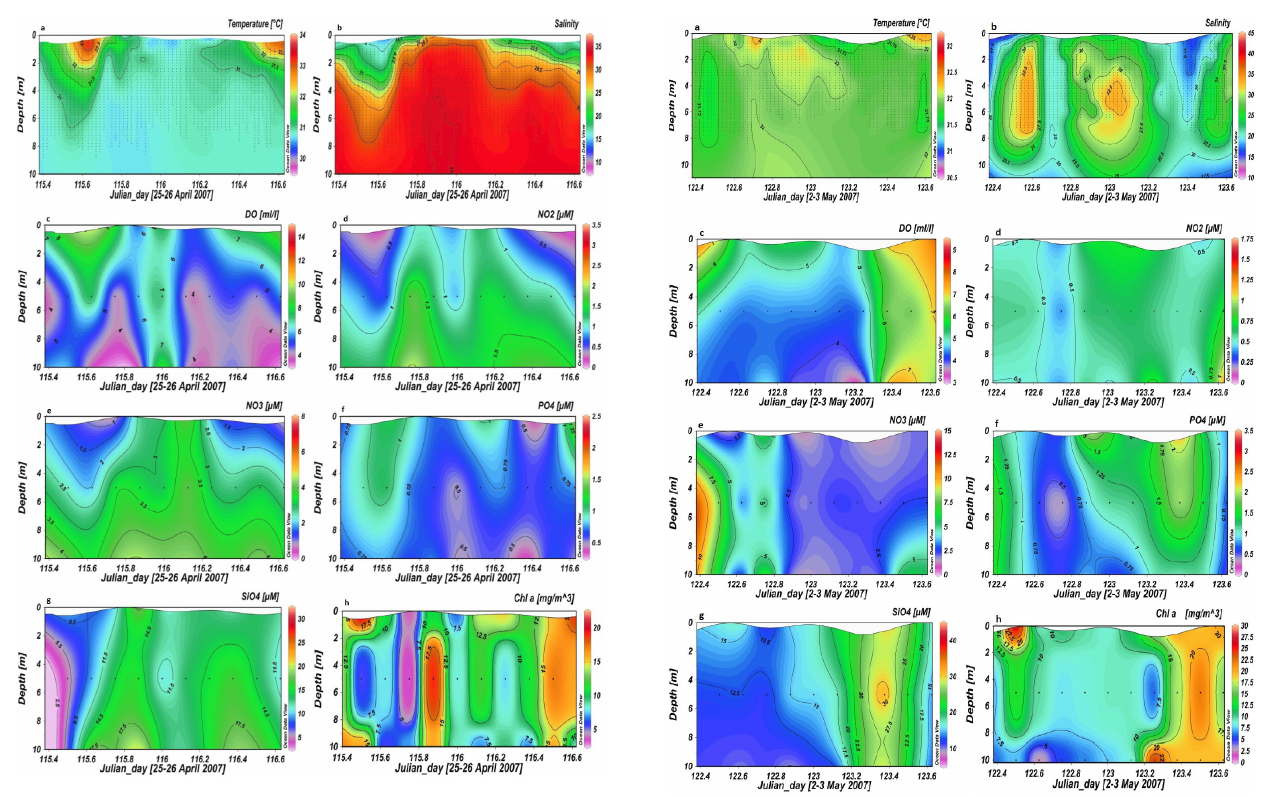
Fig. 5. Depth–time contours of salinity, temperature, DO, chloro- phyll a , NO 2 , NO 3 , PO 3 , SiO 4 for every three hours from surface, 4 4 mid-depth and bottom during spring tide of dry